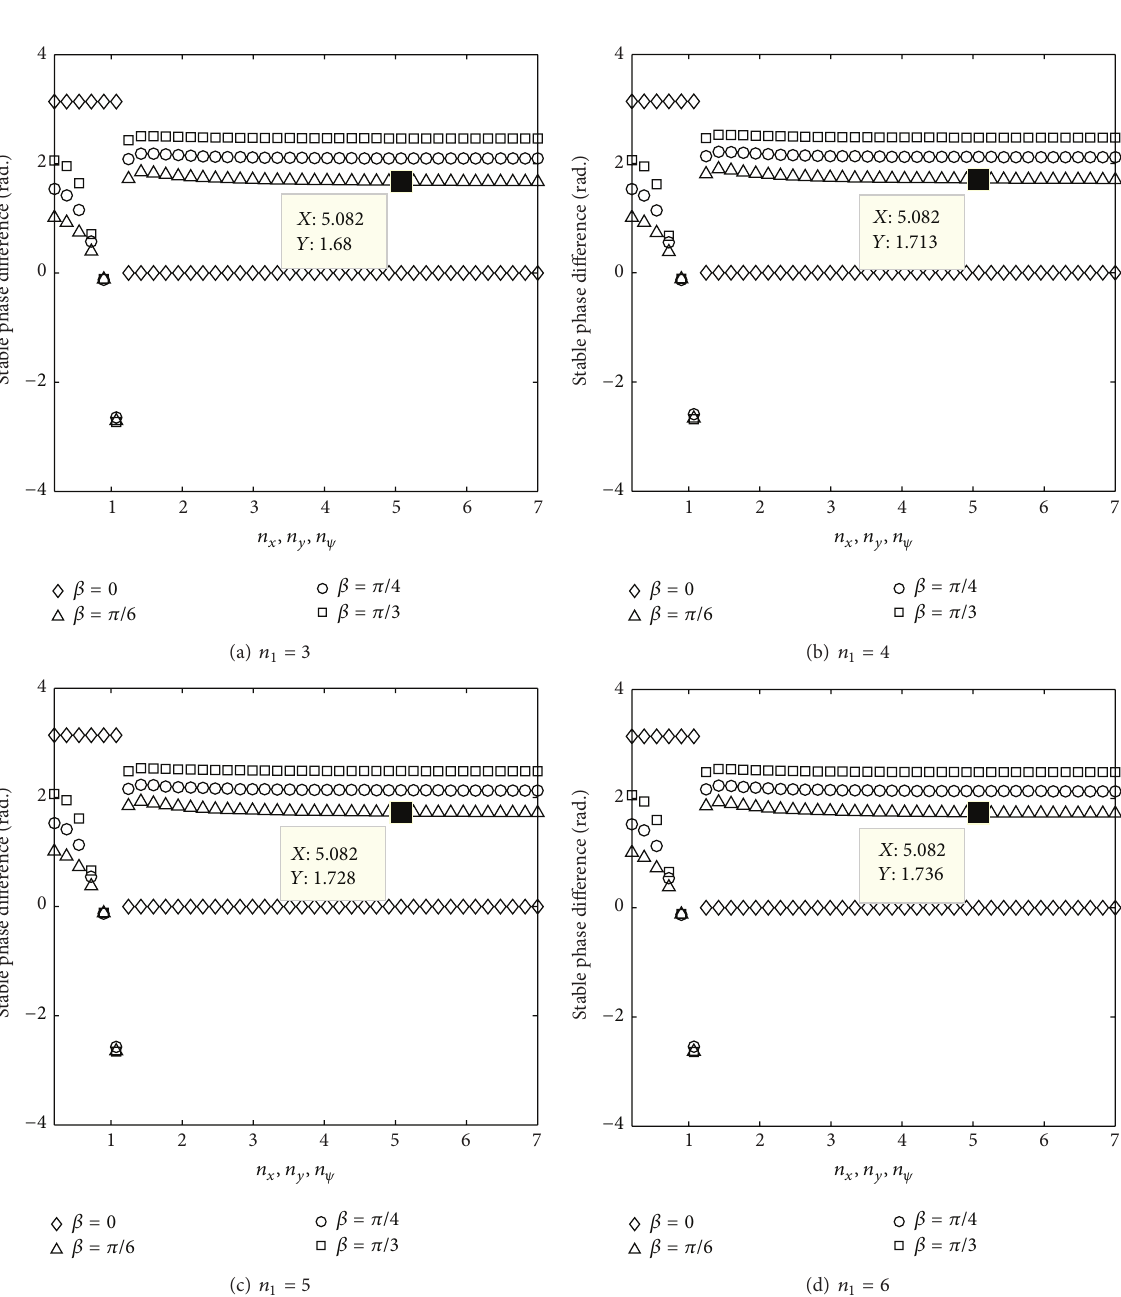
Figure 6: Stable phase difference for SBCWA and SACWA considering 𝜂 13 = 5 , 𝜂 23 = 1 , 𝑟 𝑜 = 2, 𝑟 𝑙 = 0.08 , and 𝑙 = 0.6 : (a) 𝑛 1 = 3 , (b) 𝑛 1 = 4 , (c) 𝑛 1 = 5 , and (d) 𝑛 1 = 6